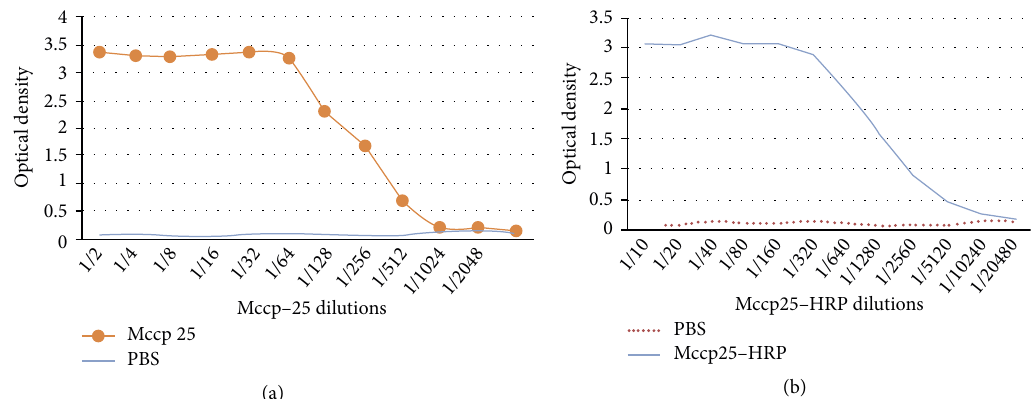
Figure 4: Titration of mAb (a) represents the titration of Mccp-25 on Mccp antigen followed by addition of antimouse conjugate (Dako), (b) represents the titration of detection antibody (Mccp25-HRP conjugate) directly to the optimal concentration of Mccp protein.